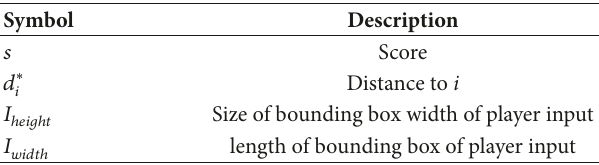
Table 11: Description of Formula Score Final